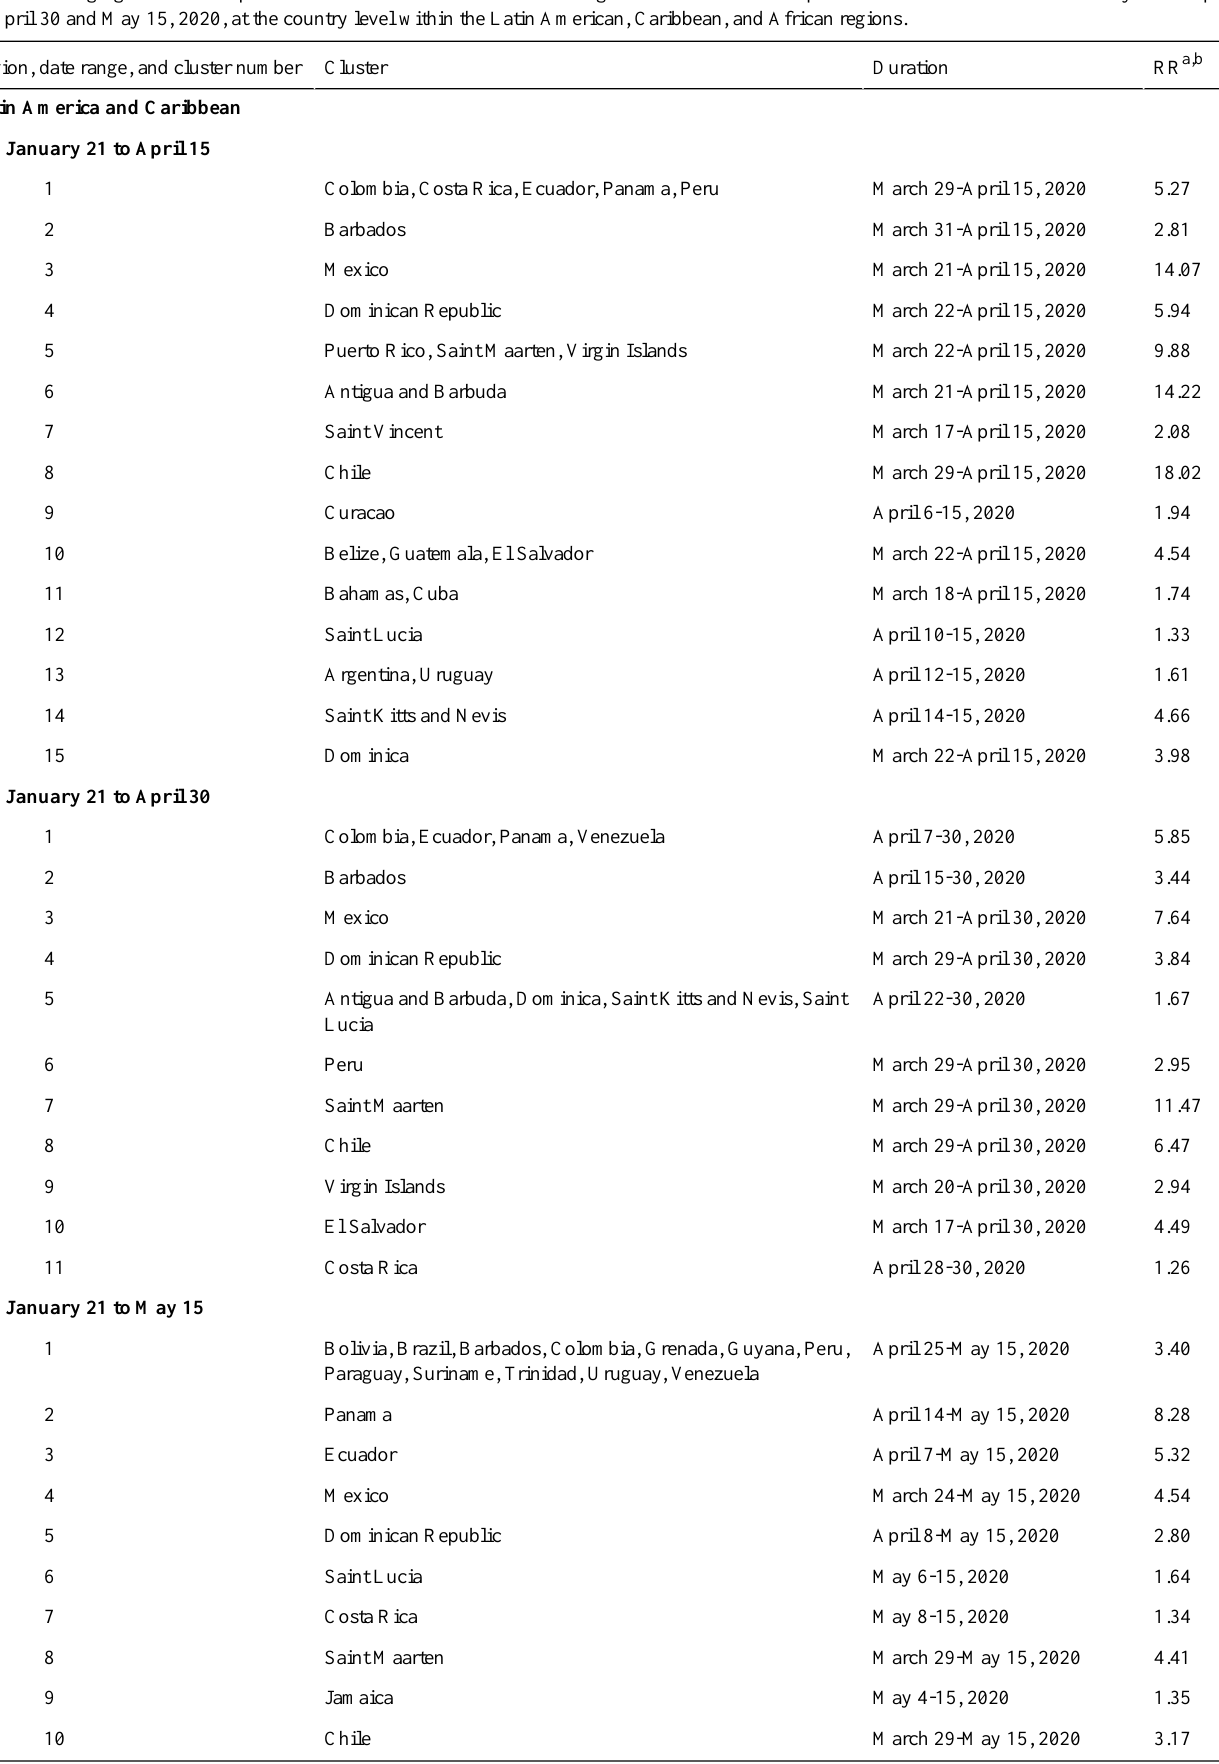
Table 2. Emerging COVID-19 space–time clusters and their RR for having more observed than expected COVID-19 cases from January 21 to April 15, April 30 and May 15, 2020, at the country level within the Latin American, Caribbean, and African regions. Latin America and